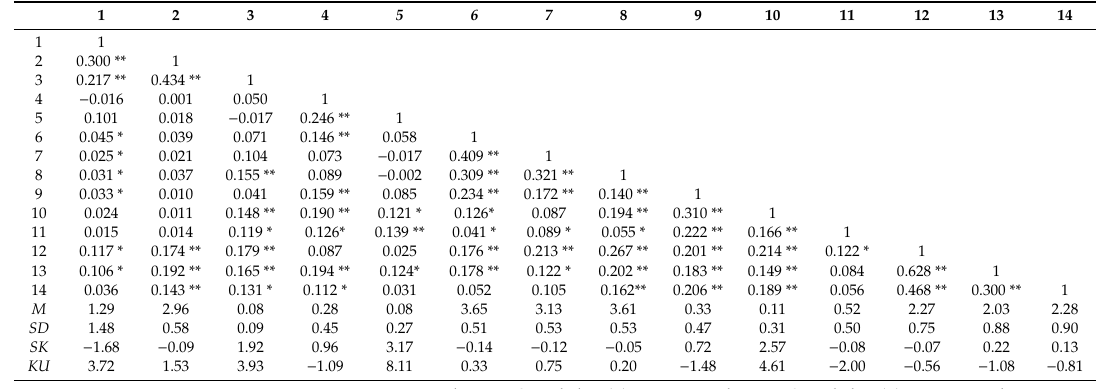
Table 5. Mean, standard deviation, and correlation matrix ( n =